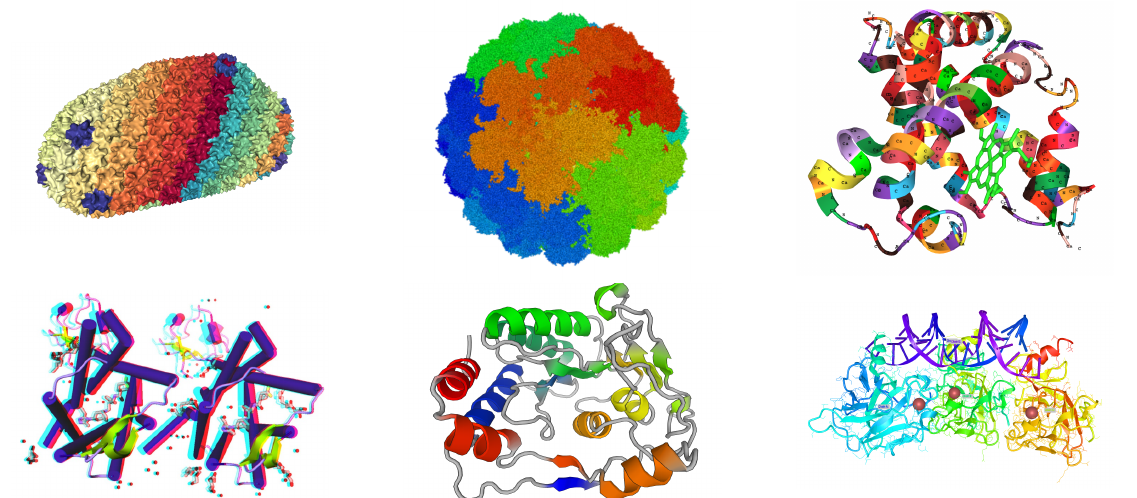
Figure 5. Gallery with various example screenshots from different interactive web-based molecule viewers. Top from left to right: (1) NGL viewer [67] showing surface of HIV-1 colored by chainindex from http://proteinformatics.charite.de/ngl; (2) Mwalongo et al. [17] displays a papillomavirus with 1.3 M atoms; (3) Web3DMol showing a Myoglobin molecule from a seal [64], retrieved from https://web3dmol.net/; Bottom row from left to right: (1) iview [53] rendering a CCR5 chemokine receptor-HIV entry inhibitor maraviroc complex with the anaglyph effect using chromatically opposite colors for stereoscopic effect; (2) a molecule from PV [50]; (3) iCn3d displaying a tumor suppressor in spectrums color with DNA [70] from